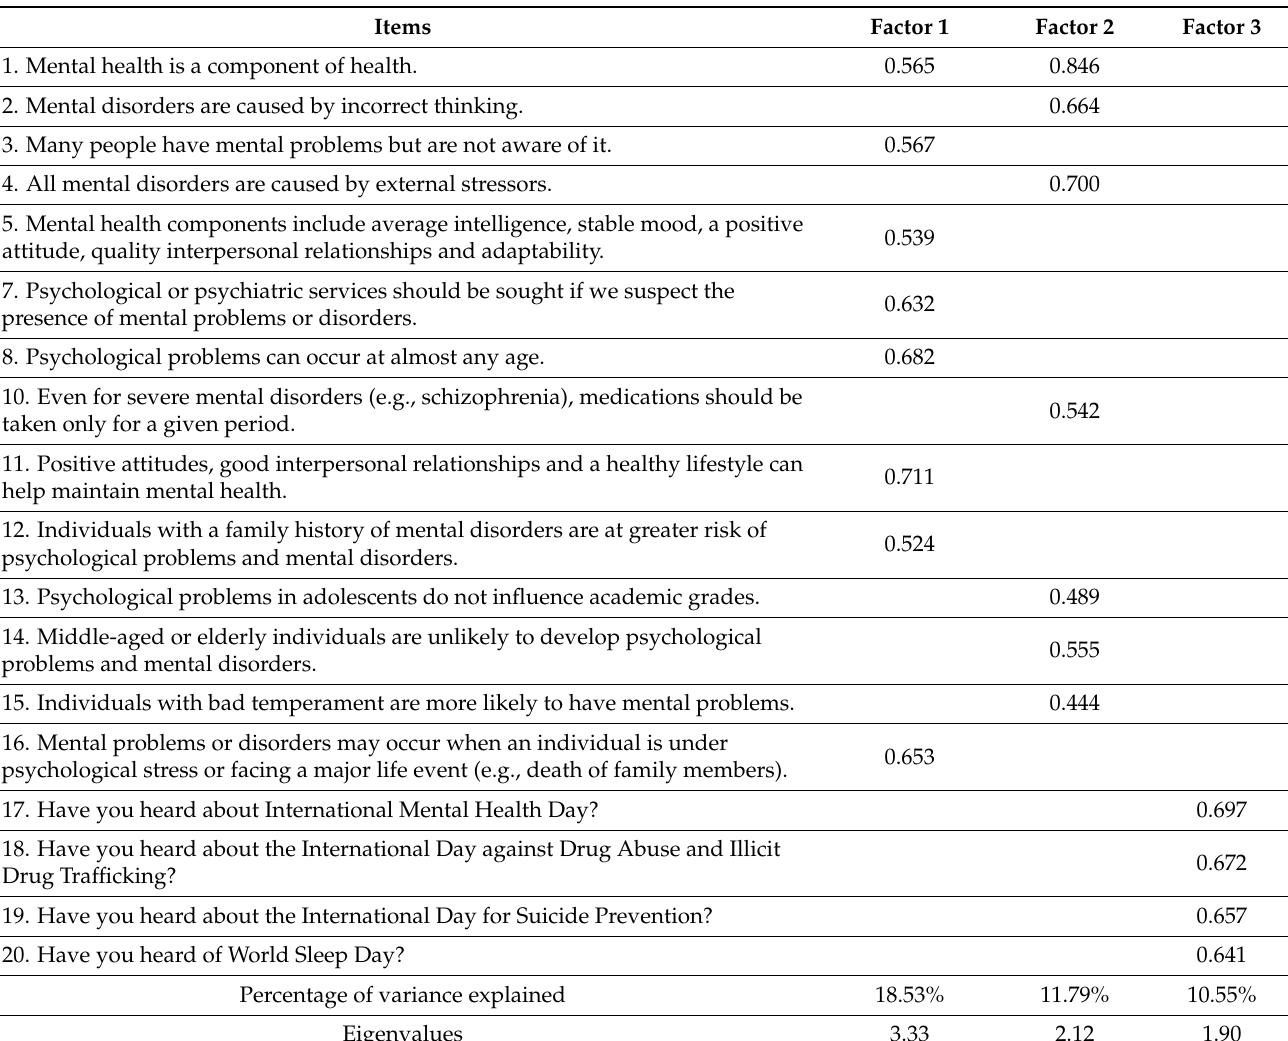
Table 2. Loadings of the items per factor, percentage of variance explained, and eigenvalues after